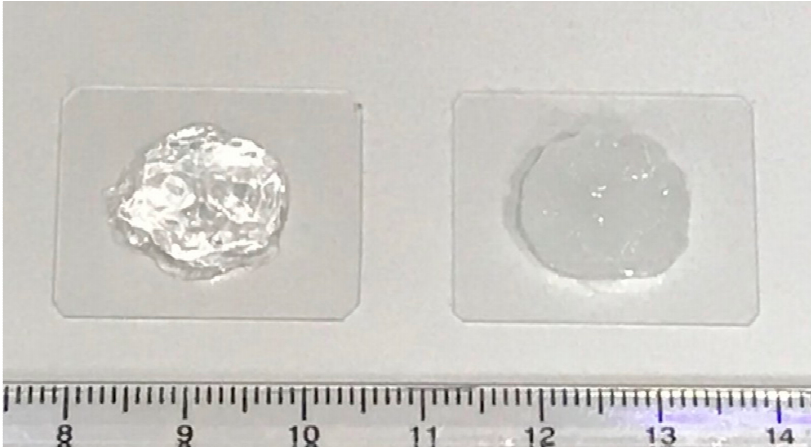
Table 2. Homogeneity results for phenethyl isothiocyanate (PEITC) carbomer gels 1 .